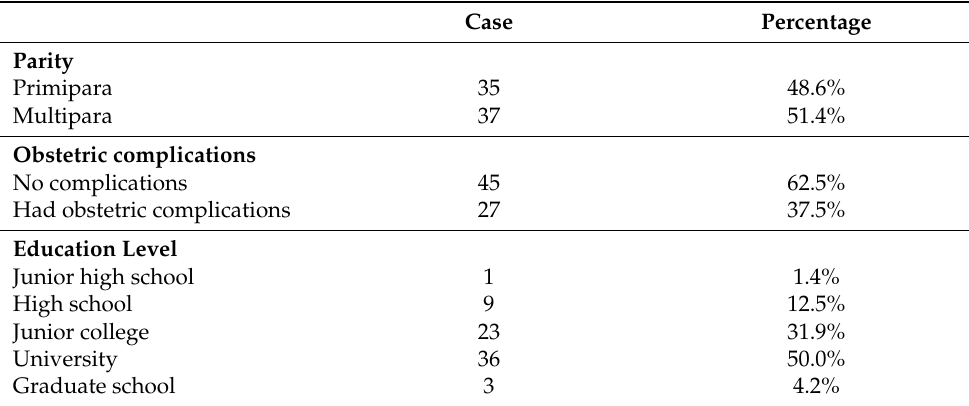
Table 1. General and obstetric characteristics of the participants.